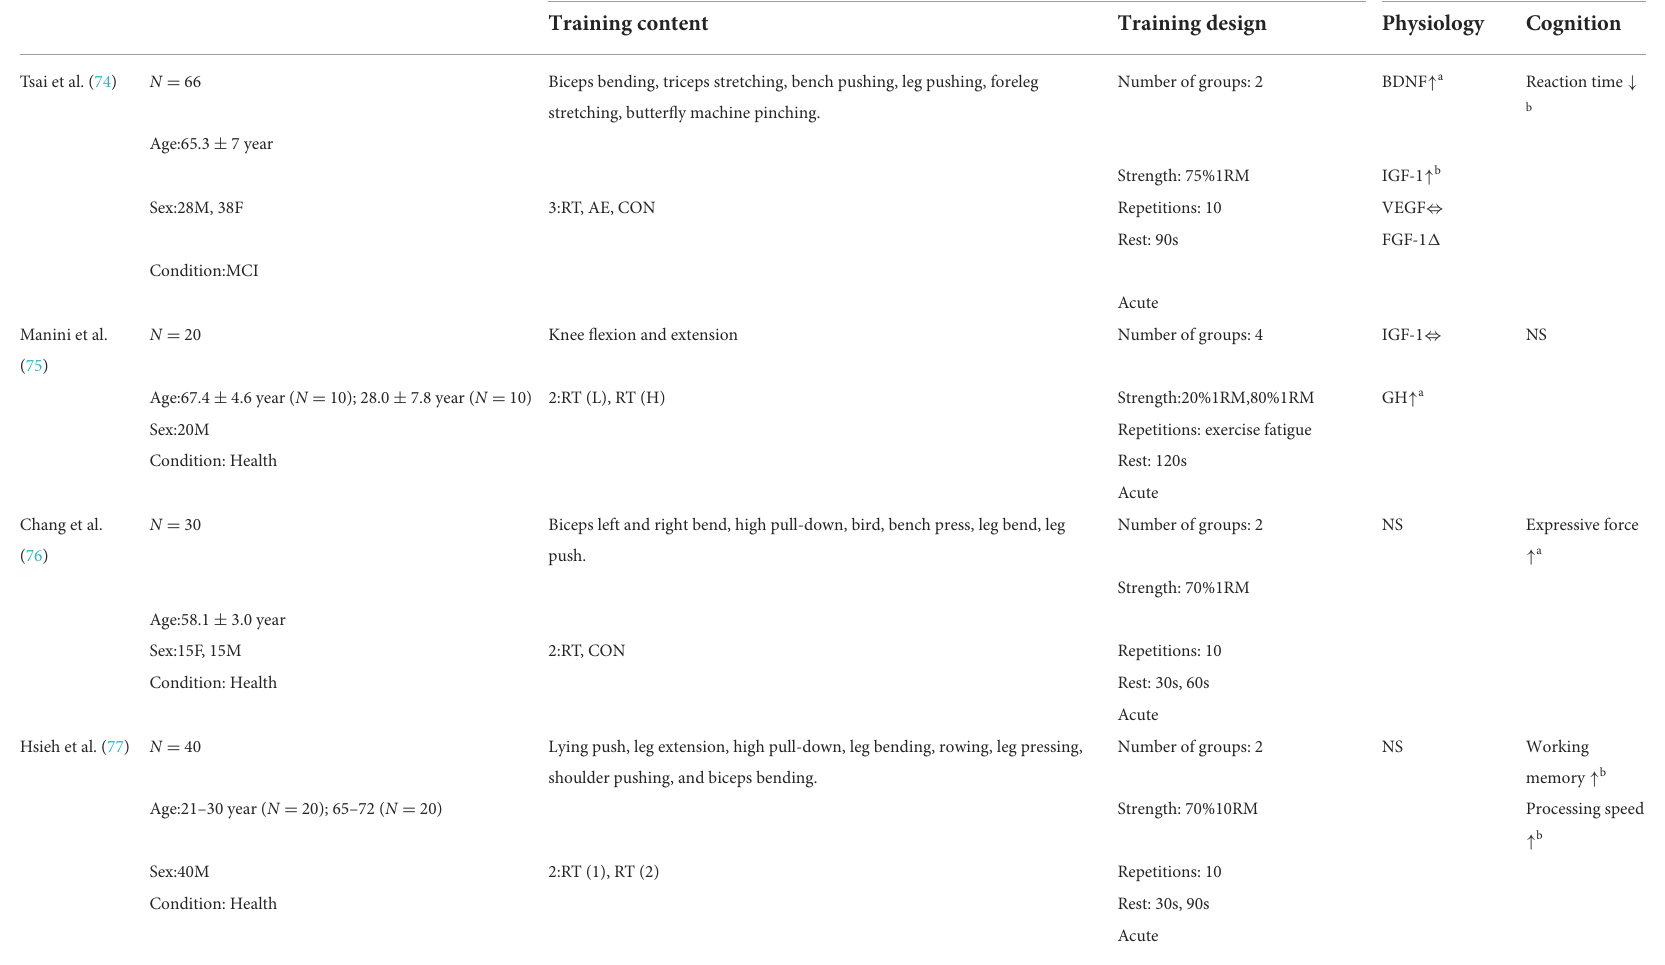
TABLE 1 Effect of acute resistance exercise on the cognitive function of the